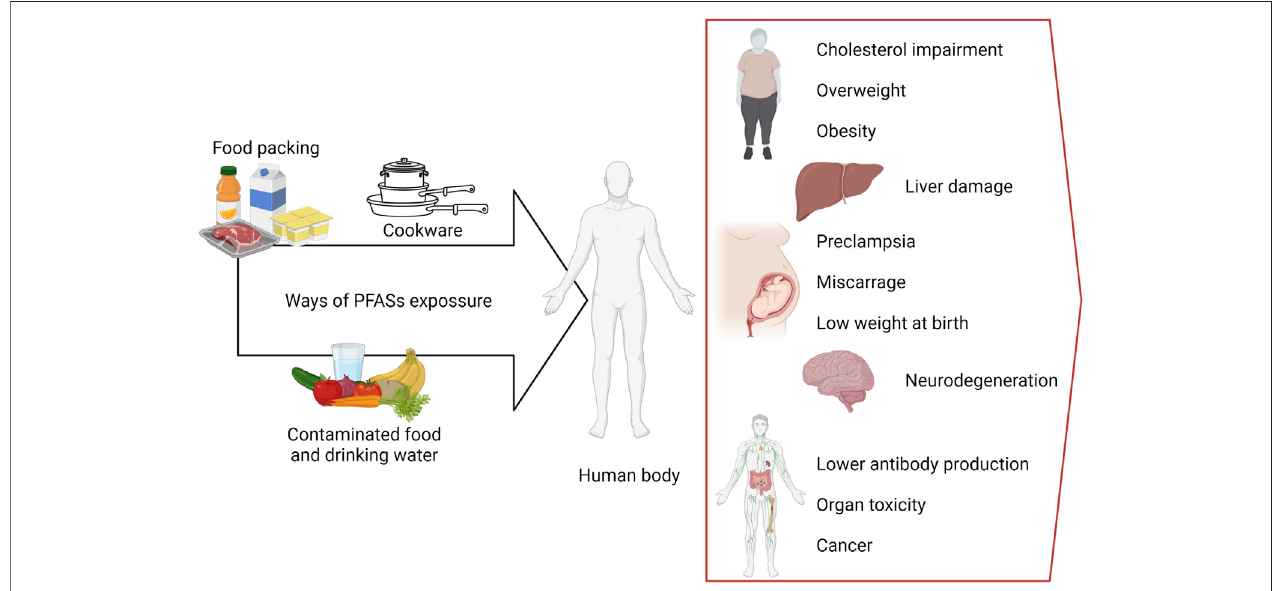
FIGURE 4 | Main effects of per- and poly fl uoroalkyl substances (PFAS) on human health. Through contaminated sources such as drinking water or food, PFAS mainly cause endocrine disruption that could promote metabolic diseases, organ damage, fetal distress, neurodevelopment alterations and immunotoxicity. Created with